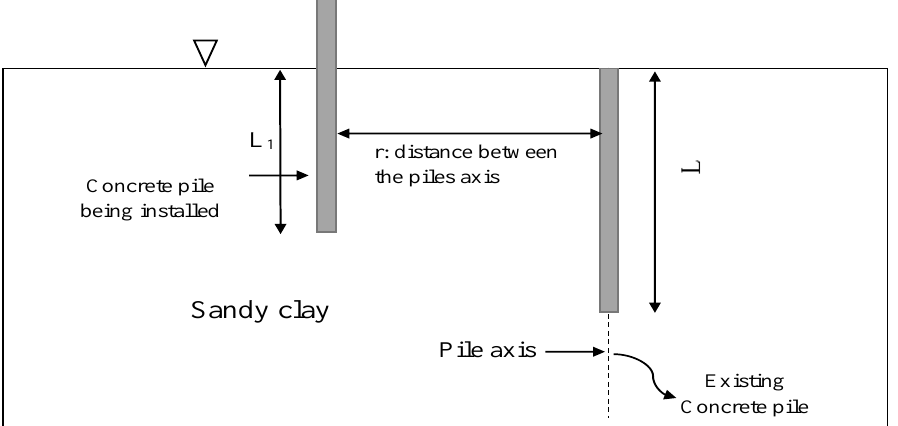
Figure 1. Driven pile near the already-installed pile.